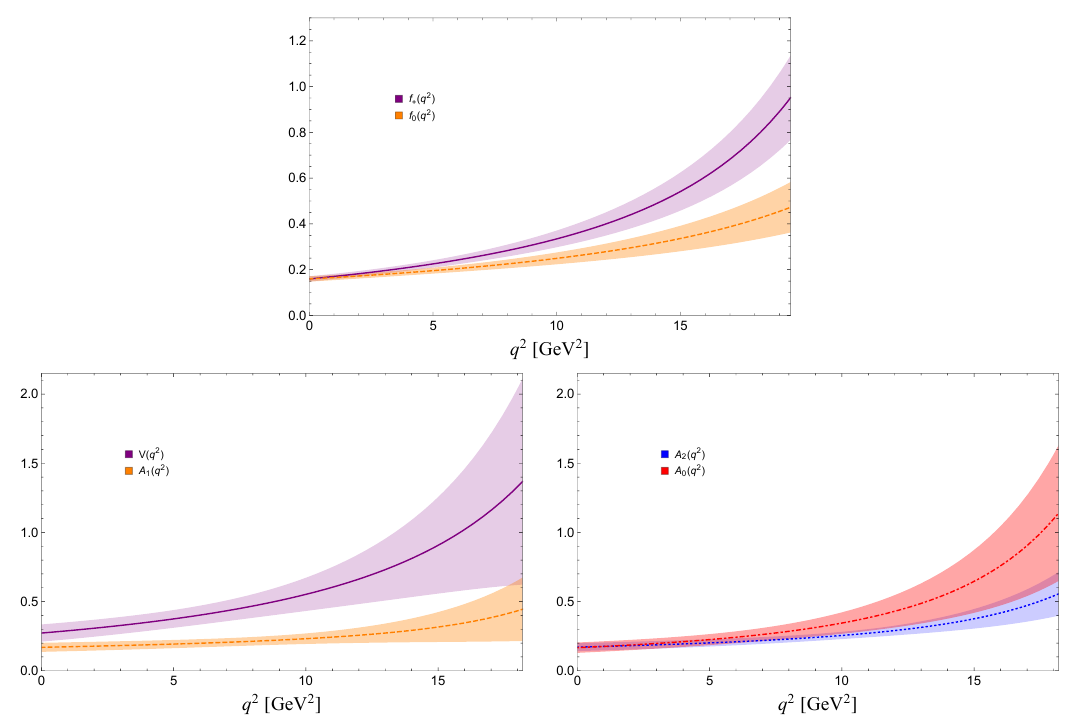
Figure 3 . Final predictions for B c ! D ( (cid:3) ) form factors obtained by extrapolating 3ptSR results to higher q 2 regions by using the BCL parametrizations.